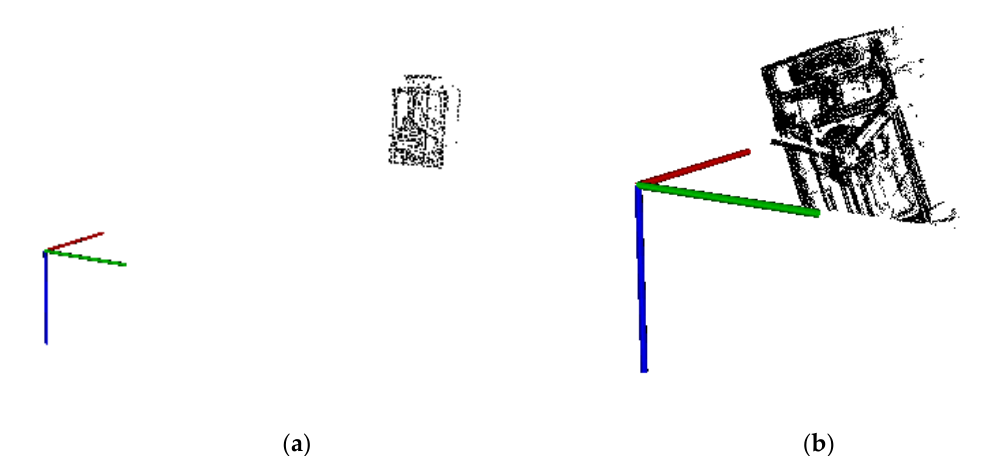
Figure 5. An example of the simulated point cloud data (the sensor locates at different view position, ( a ) the distance is 10 m; ( b ) the distance is 2 m).